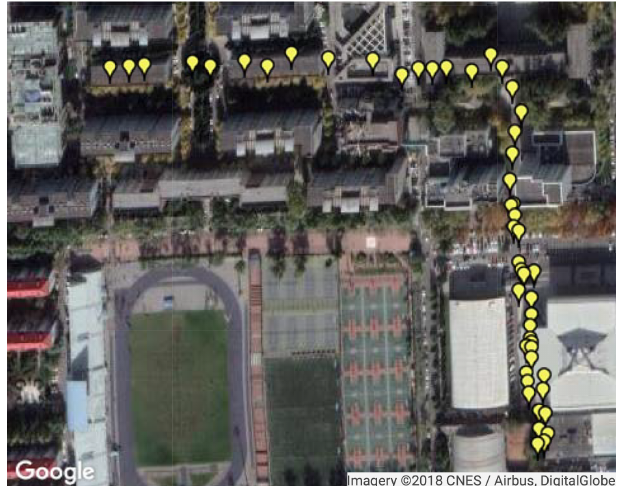
Figure 5. The first test site and test points. The yellow markers on the map denote the test